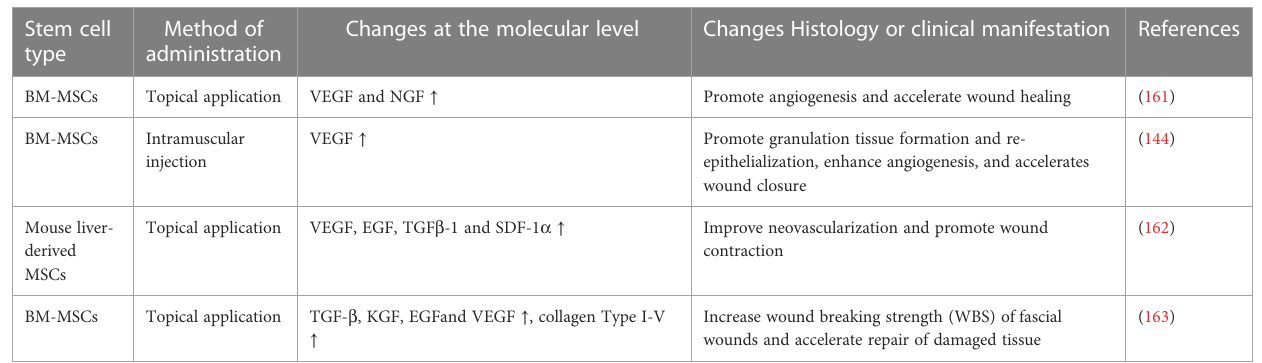
TABLE 1 Potential role of MSCs in the healing of diabetic foot.